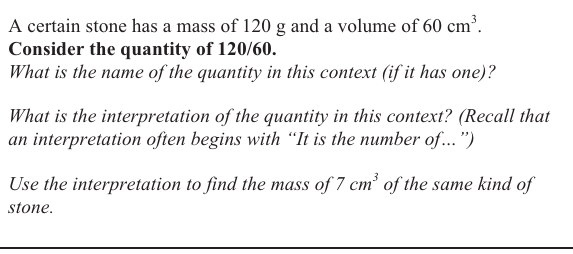
FIG. 4. Excerpt from a tutorial on the properties